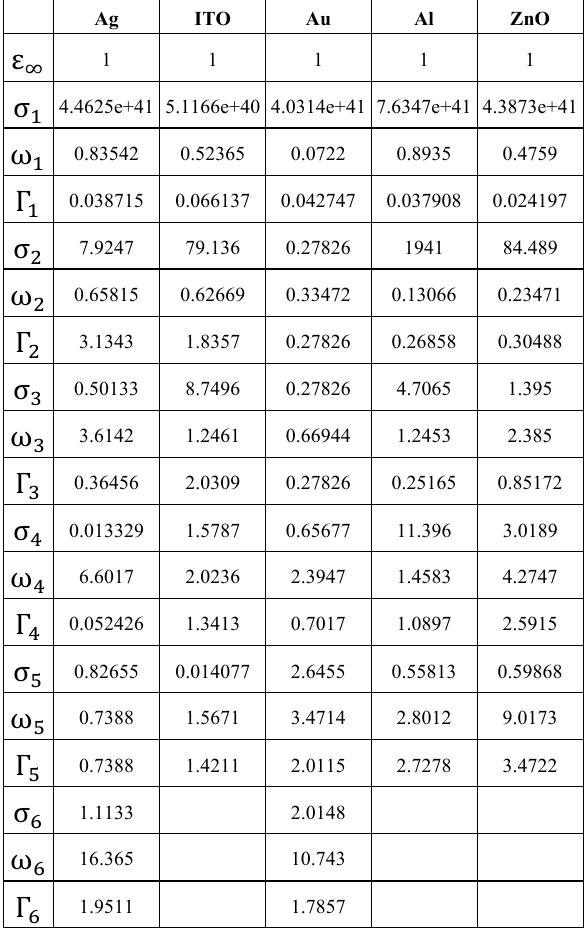
TABLE I. LD FITTING PARAMETERS FOR A G , ITO, A U , A L AND Z N O